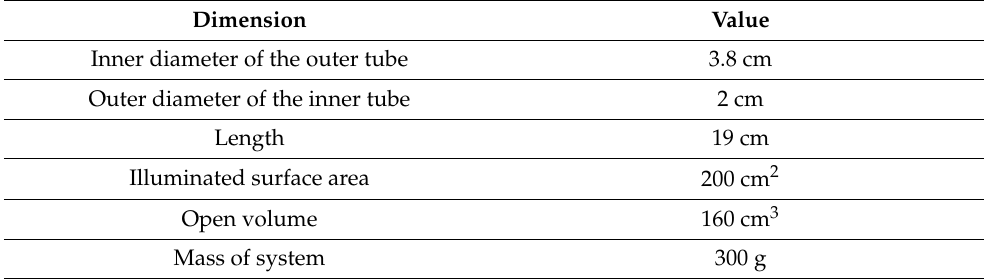
Table 2. Dimensions of UV LED photocatalytic